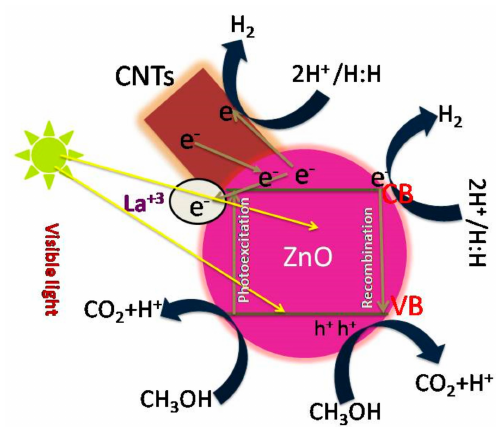
Figure 10. Illustration of the mechanism of H 2 evolution over the La/ZnO/CNTs